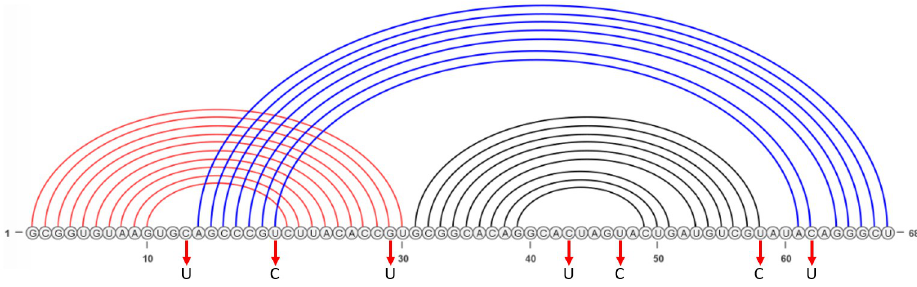
Fig 2. SARS-CoV-2 − 1 PRF pseudoknot native structure. Stem 1 in red, Stem 2 in black, and pseudoknotted Stem 3 in blue. Visualization generated using VARNA [11]. Mutations of interest shown with red arrows.